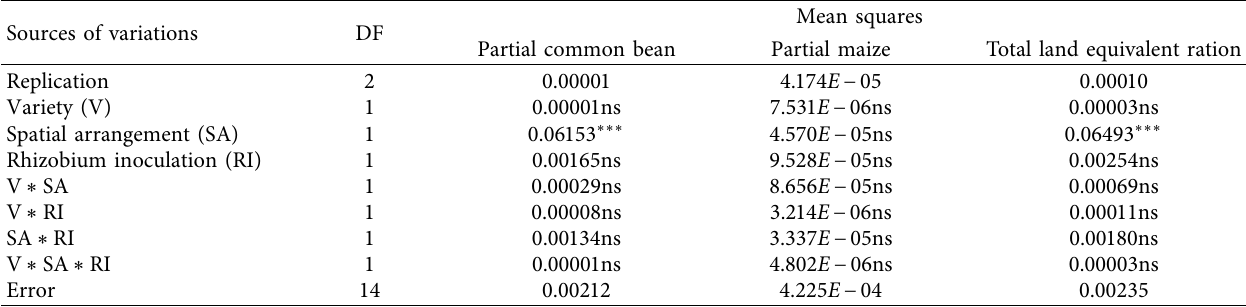
Table 11: Mean squares from analysis of variance (ANOVA) for partial and total land equivalent ratio from the common bean-maize intercropping.